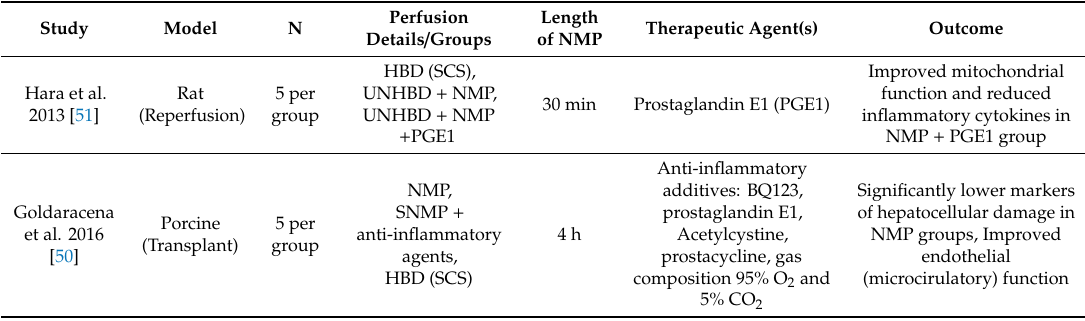
Microcirculation